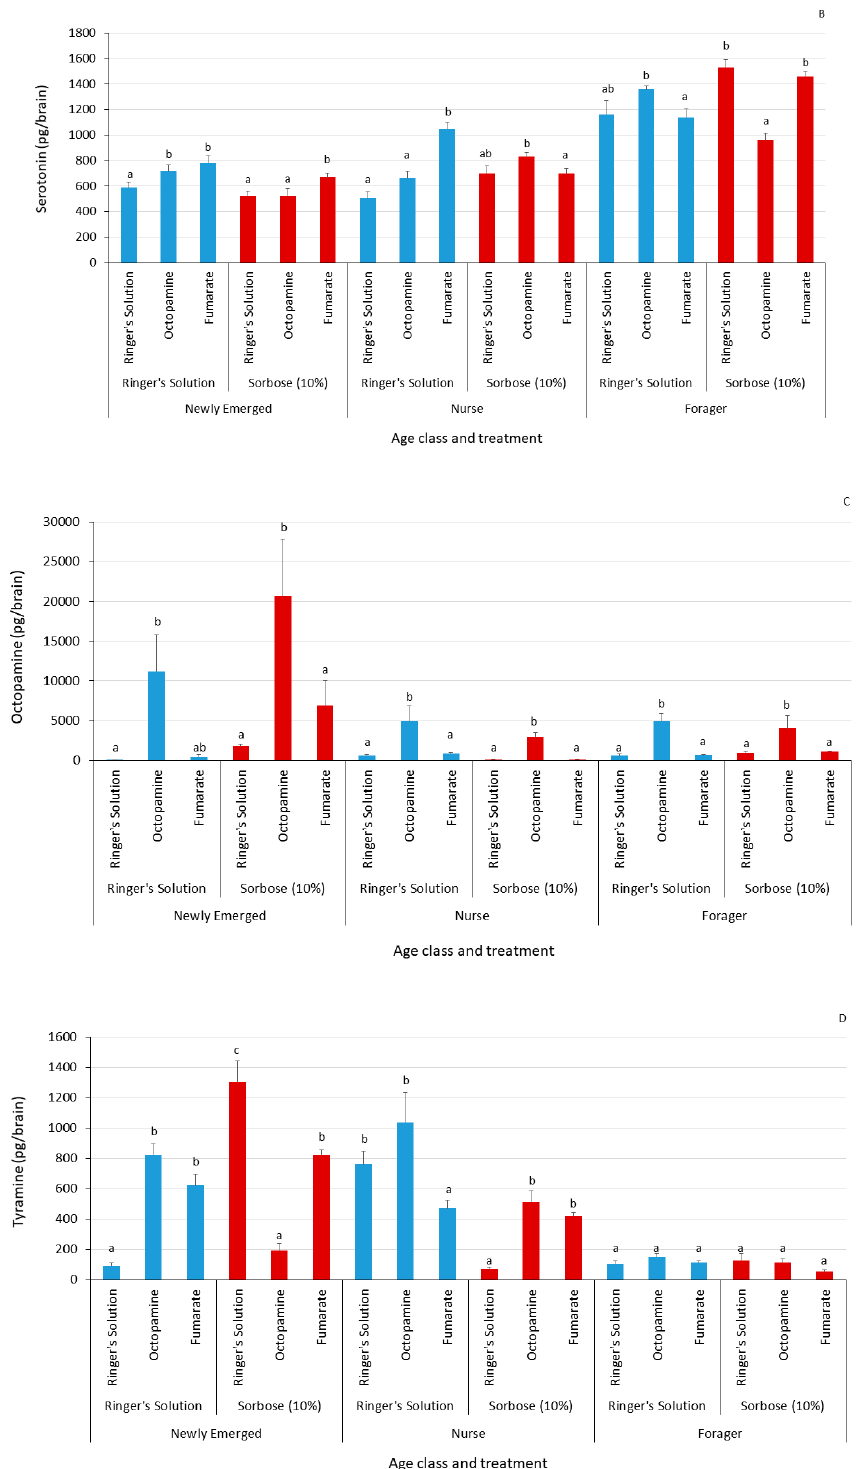
Figure 3. The biogenic amine levels for ( A ) dopamine, ( B ) serotonin, ( C ) octopamine, and ( D ) tyramine measured after the proboscis extension response assay at the end of the experiment. Each bar represents the mean and the error bars represent standard errors. The bars are grouped by the thorax injection treatment within their respective age class. Each bar corresponds to the brain injection treatment administered before the proboscis extension response assay. The letters above each bar represent significant differences at the alpha = 0.05